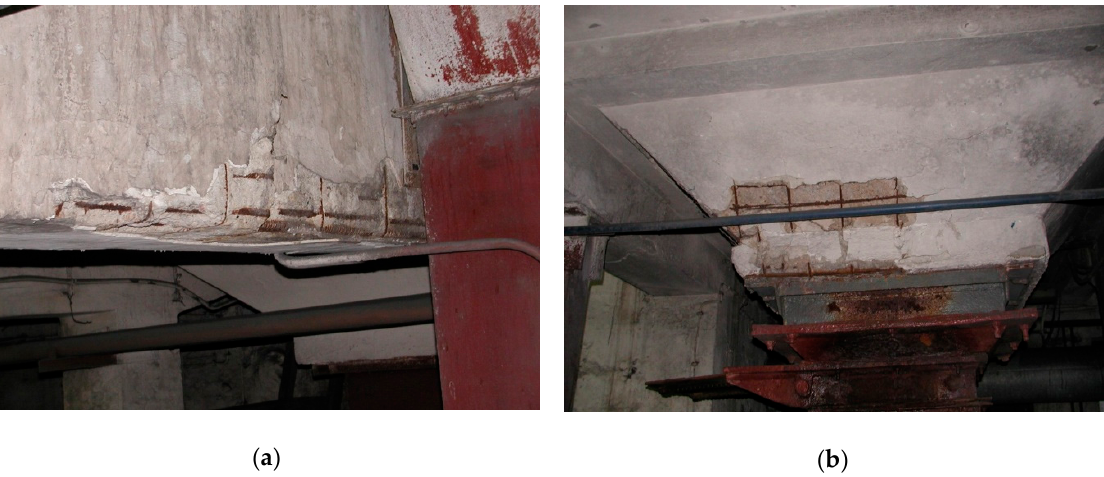
Figure 2. Examples of corrosive damage: ( a , b ) corrosion of steel rebars in defected concrete cover.